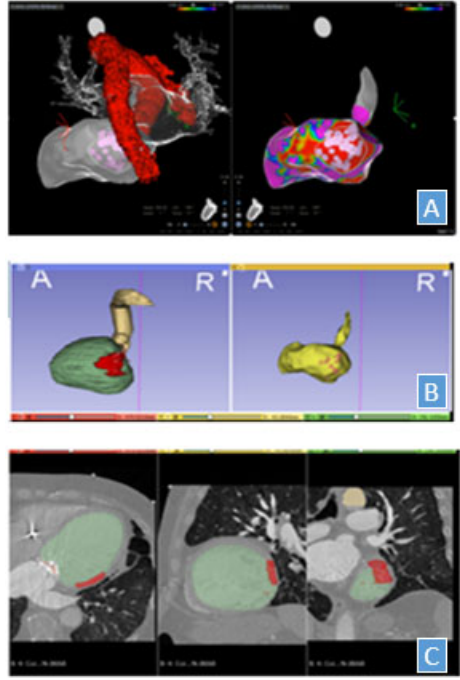
Figure 2. Electroanatomical mapping (EAM) with the marked ablation target were projected onto 4DCT images by landmark registration. ( A ) EAM ‐ the color scale represents a bipolar mapping with extremes of 0.5 and 1.5 mV; ( B ) 3D SLICER software used to project EAM onto 4DTC On the left is presented the rendering of the structures delineated on the CT and registered on the EAM reported on the right; ( C ) Corresponding structures in 4DCT scan.